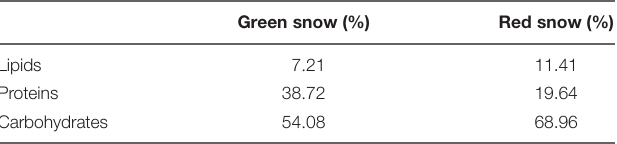
TABLE 8 | Bulk functional group distribution of green and red